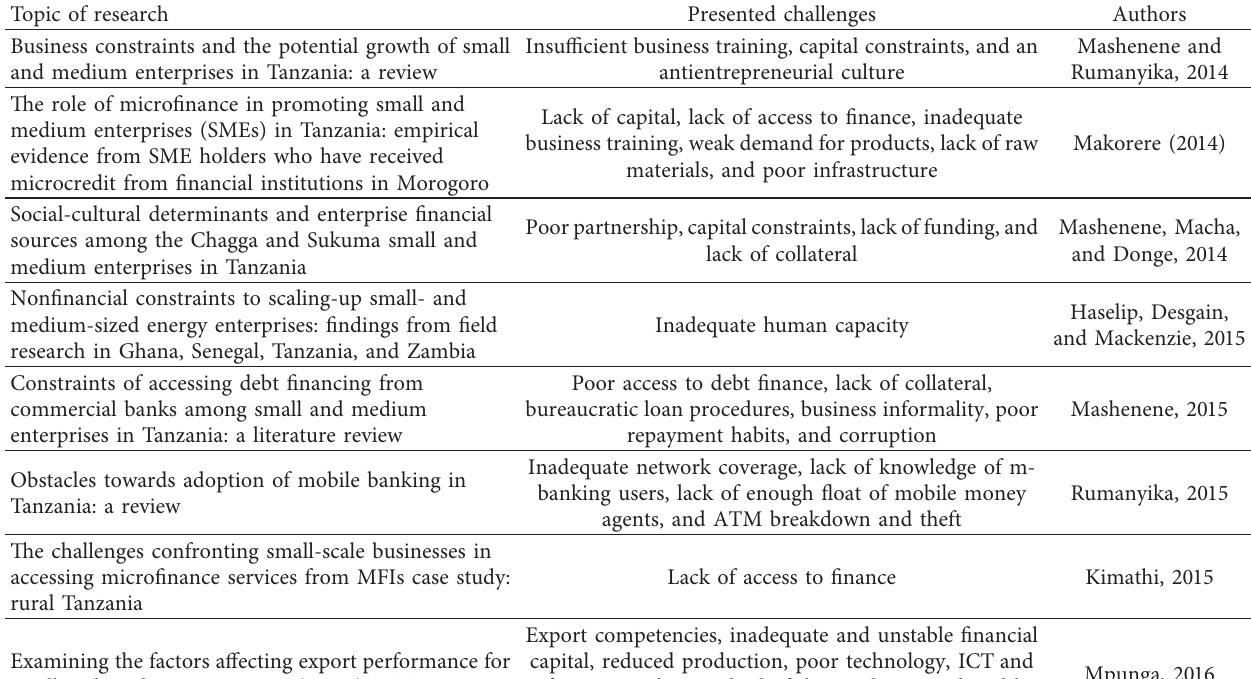
Table 3: Selected studies on SME predominant challenges in